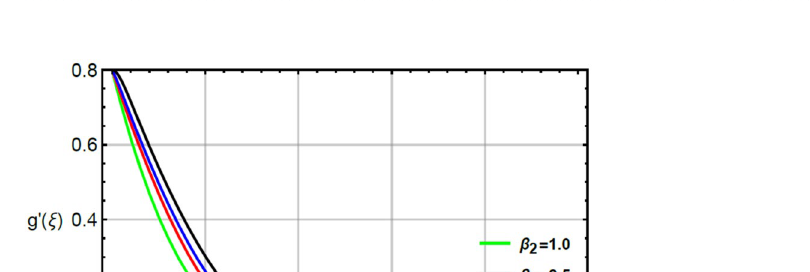
Figure 6. Character of β 1 on g ′ .